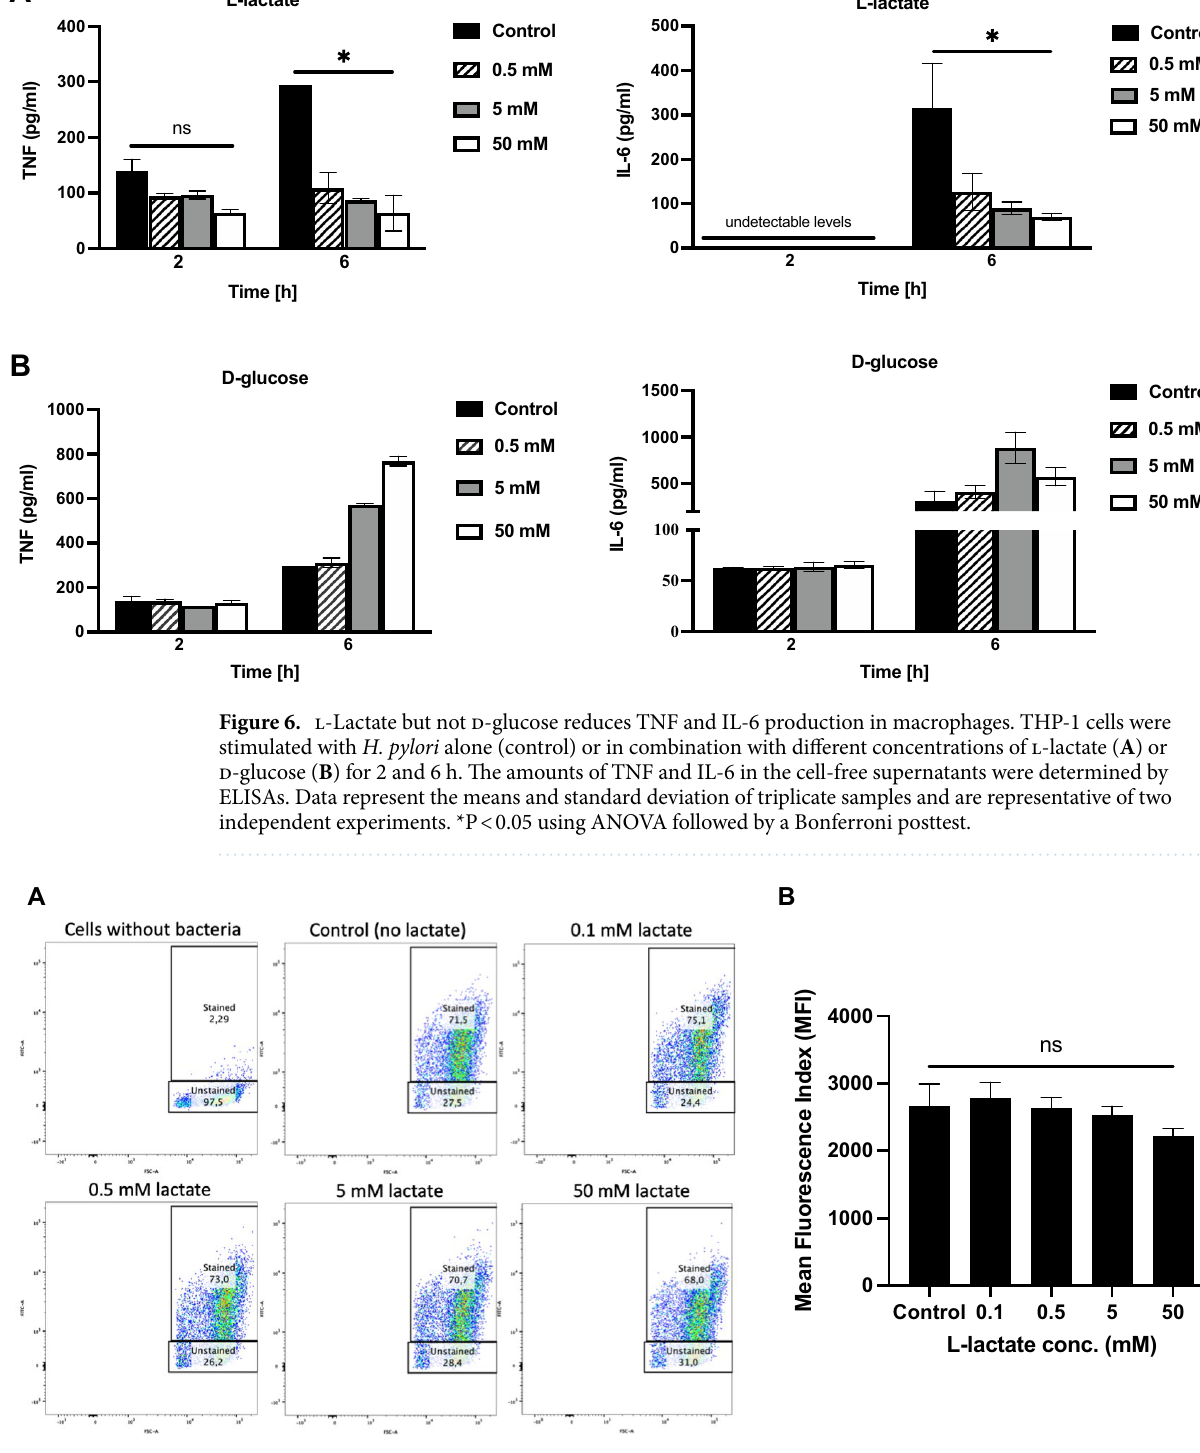
Figure 7. The phagocytic ability of H. pylori -infected macrophages remains unaltered by the presence of lactate. THP-1 cells were stimulated with CFSE-stained H. pylori alone (control) or in combination with different concentrations of l-lactate for 6 h. The number of phagocytosed bacteria was measured by flow cytometry ( A ). The mean fluorescence index (MFI) of the cells was also measured, confirming that there was no change in the phagocytosis of H. pylori in the presence of lactate ( B ). Data represent the means and standard deviation of triplicate samples and are representative of three independent experiments. ns, nonsignificant, using ANOVA followed by a Bonferroni